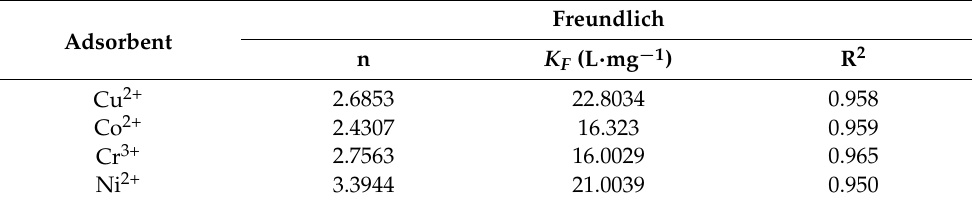
Table 4. Freundlich adsorption isotherm (linear) parameters of poly(hydroxamic acid) ligand. Adsorbent